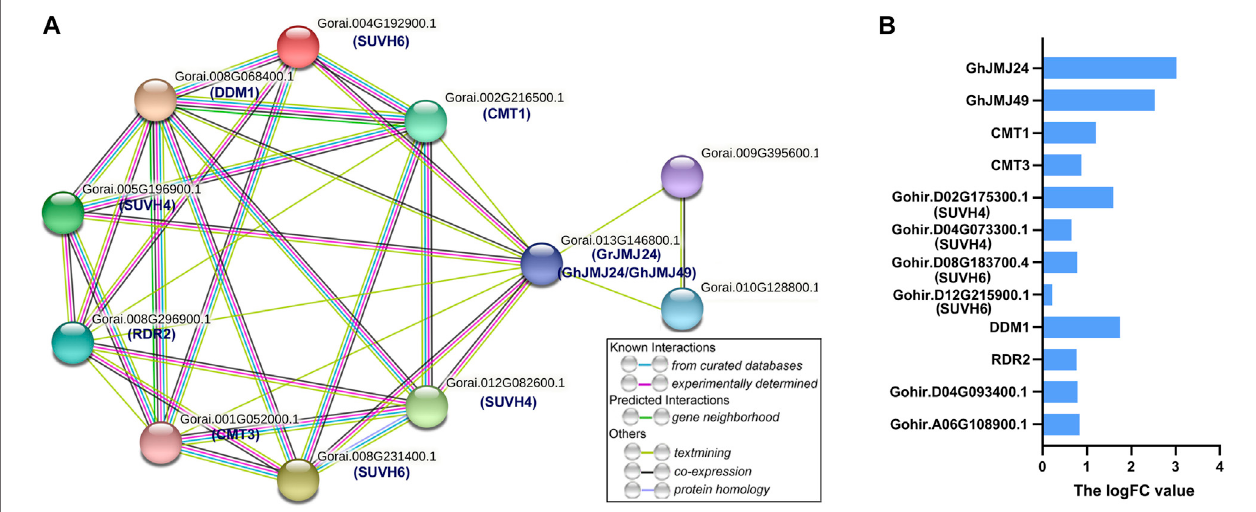
FIGURE8| Theprotein interaction networkof GhJMJ24 and GhJMJ49 and teninteractive genesexpression. (A) The interaction networkofGhJMJs homologues in G. raimondii . Network nodes represent proteins. Edges represent protein-protein associations and color shows association types. Known interactions: from curated databases; experimentally determined. Predicted interactions:gene neighbourhood. Others: text-mining; co-expression; protein homology. (B) Ten interactive genes expression fold changes in EC tissue compared to NEC tissue. A positive LogFC indicates